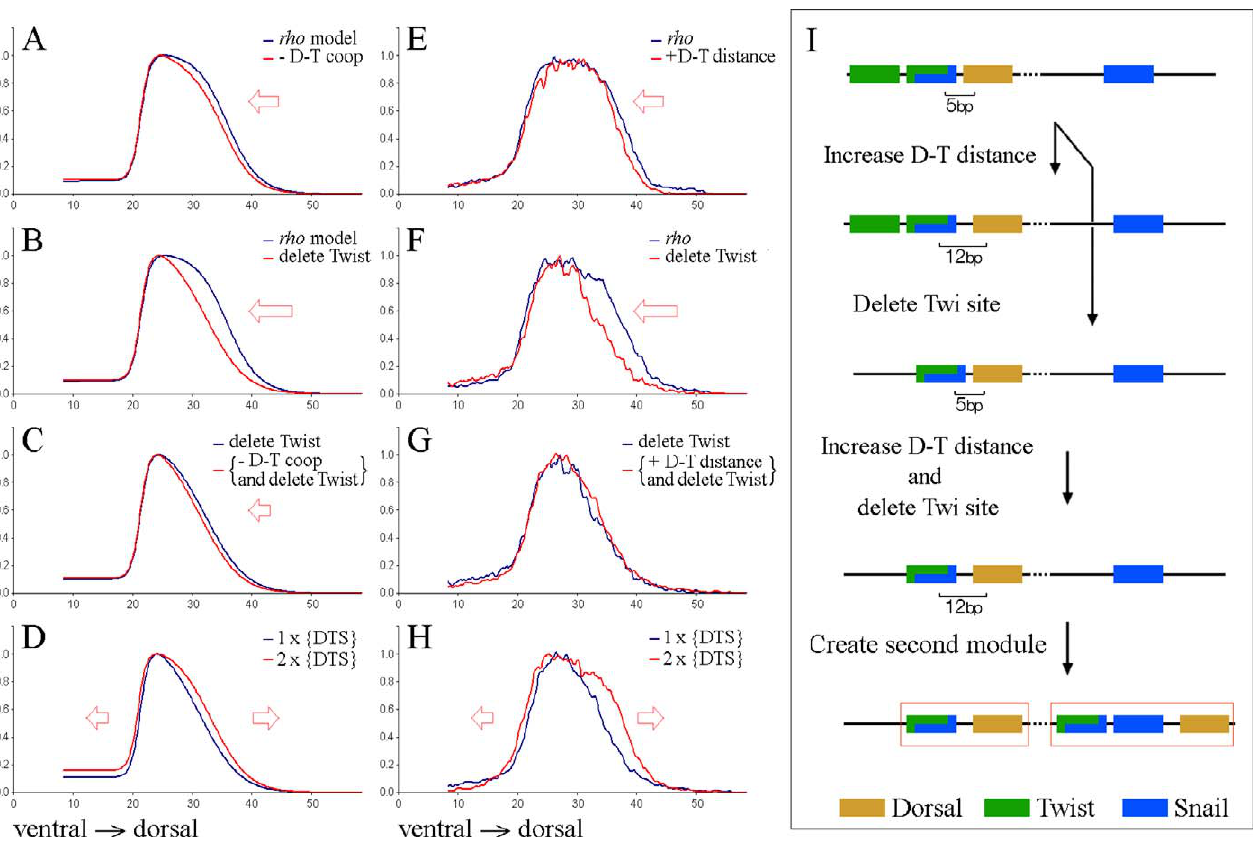
Figure 3. In Vivo Versus In Silico Responses of a Modified Enhancer Predicted responses in silico (A–D) and the observed responses in vivo as quantified in transgenic flies (E–H) of mutagenized rho enhancers. (I) Mutations incorporated in the enhancer structure (see Materials and Methods for sequences). Reducing Dorsal-Twist cooperativity in silico or increasing the distance between the Dorsal and the Twist sites in vivo results in a slight ventral shift of the dorsal expression border (compare (A) with (E)). Deleting a weak Twist site shifts the dorsal border ventrally (B,F). The combined effect of both mutations is similar to the deletion of Twist (C,G). Creation of a second DTS element (red boxes) results in an expected overall ‘‘ boost ’’ in expression, thereby shifting both the ventral and dorsal expression boundaries, ‘‘ widening ’’ the rho stripe